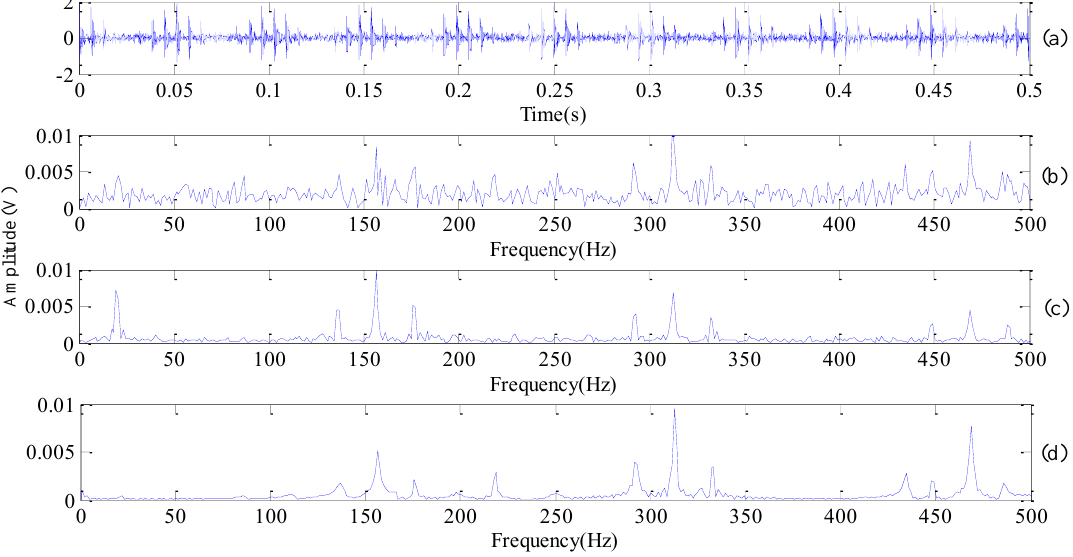
Figure 3. Improved DMD analysis with simulation signal of bearing inner race ( a ) time domain fault simulation signal; ( b ) FFT spectrum; ( c ) envelope spectrum ; ( d ) frequency spectrum with improved DMD. Table 1. The parameters selection with simulation signal of bearing inner race.